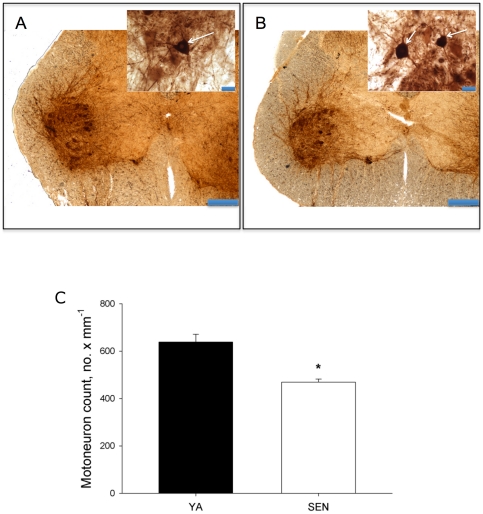
Spinal cord motoneuron counts.A: Photomicrograph of choline acetyl transferase labeled cross-sections of the spinal cord from a young adult rat and B: senescent rat (scale bar = 400 µm). Insets for both panels are higher power images showing motoneuron soma (arrows) (scale bar = 40 µm). C: mean motoneuron counts for young adult (YA) and senescent (SEN) rats. *P<0.05 versus YA.